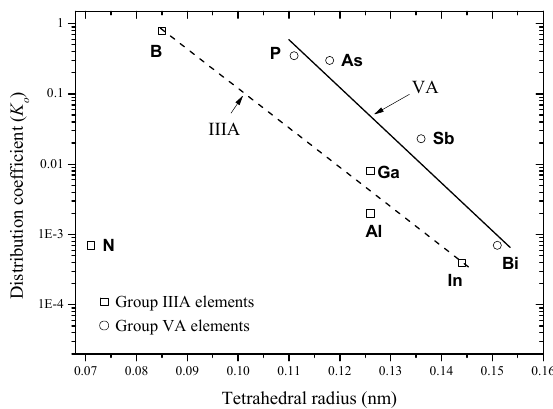
Figure 37. Distribution coefficients vs. tetrahedral radii of impurity atoms (except N) at the melting point of silicon. Table 18. Size of impurity atom relative to silicon.